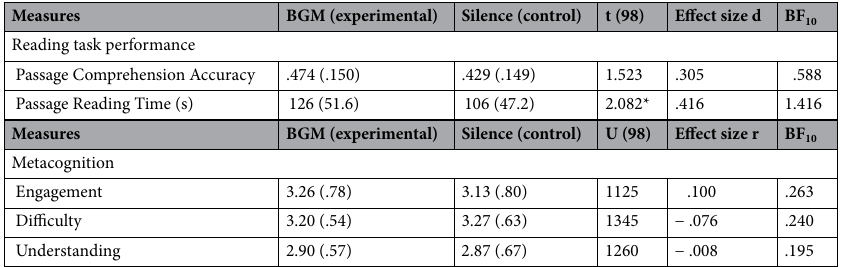
Table 4. Results of T-tests on reading task performance and results of U-tests on metacognition. N = 100 (BGM Group = 50; Silence Group = 50). * p values < 0.05 were at significant level. Effect size is given by Cohen’s d (for t-test) and rank biserial correlation r (for Mann-Whitney u-test).